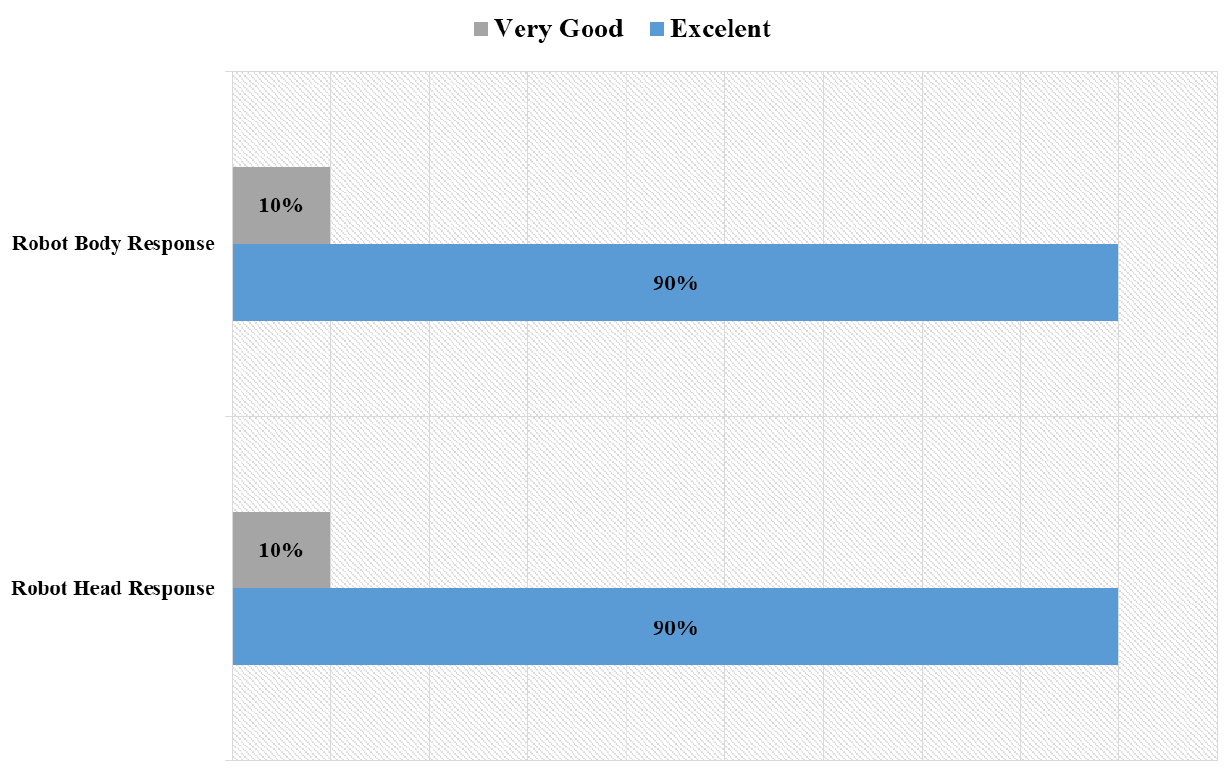
Figure 13. Feedback on mobile system components.